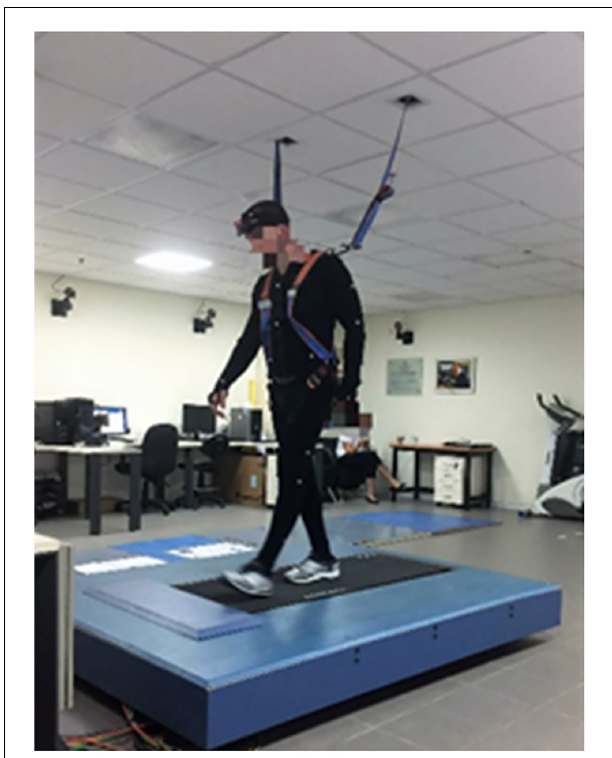
FIGURE 3 | Photo of the BaMPer system. The system is composed of a motor-driven treadmill, mounted on a moving platform, with a motion controller, a safety harness, and an operator station (see text for more